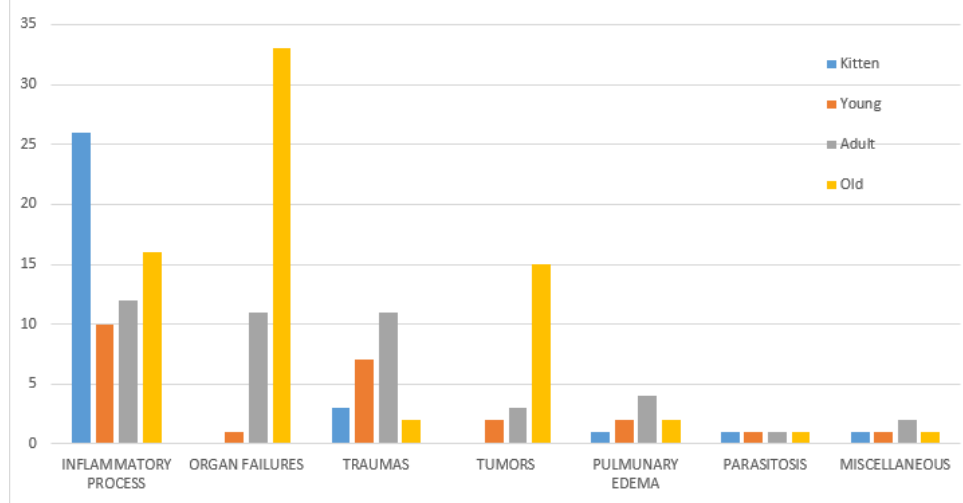
Figure 3. Relation between cause of death and sex of colony cats included in the study .